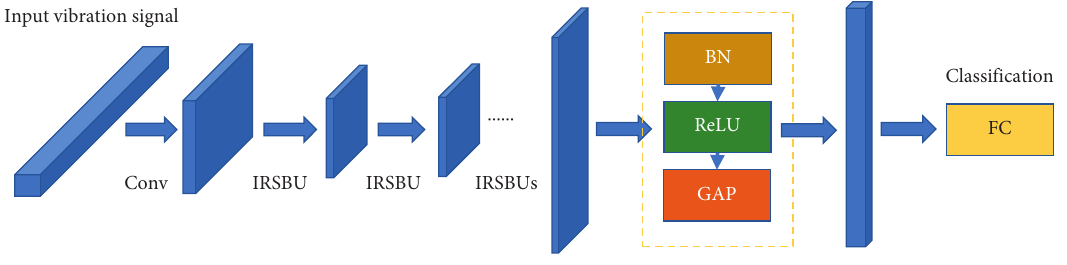
Figure 5: Architecture of the IDRSN.